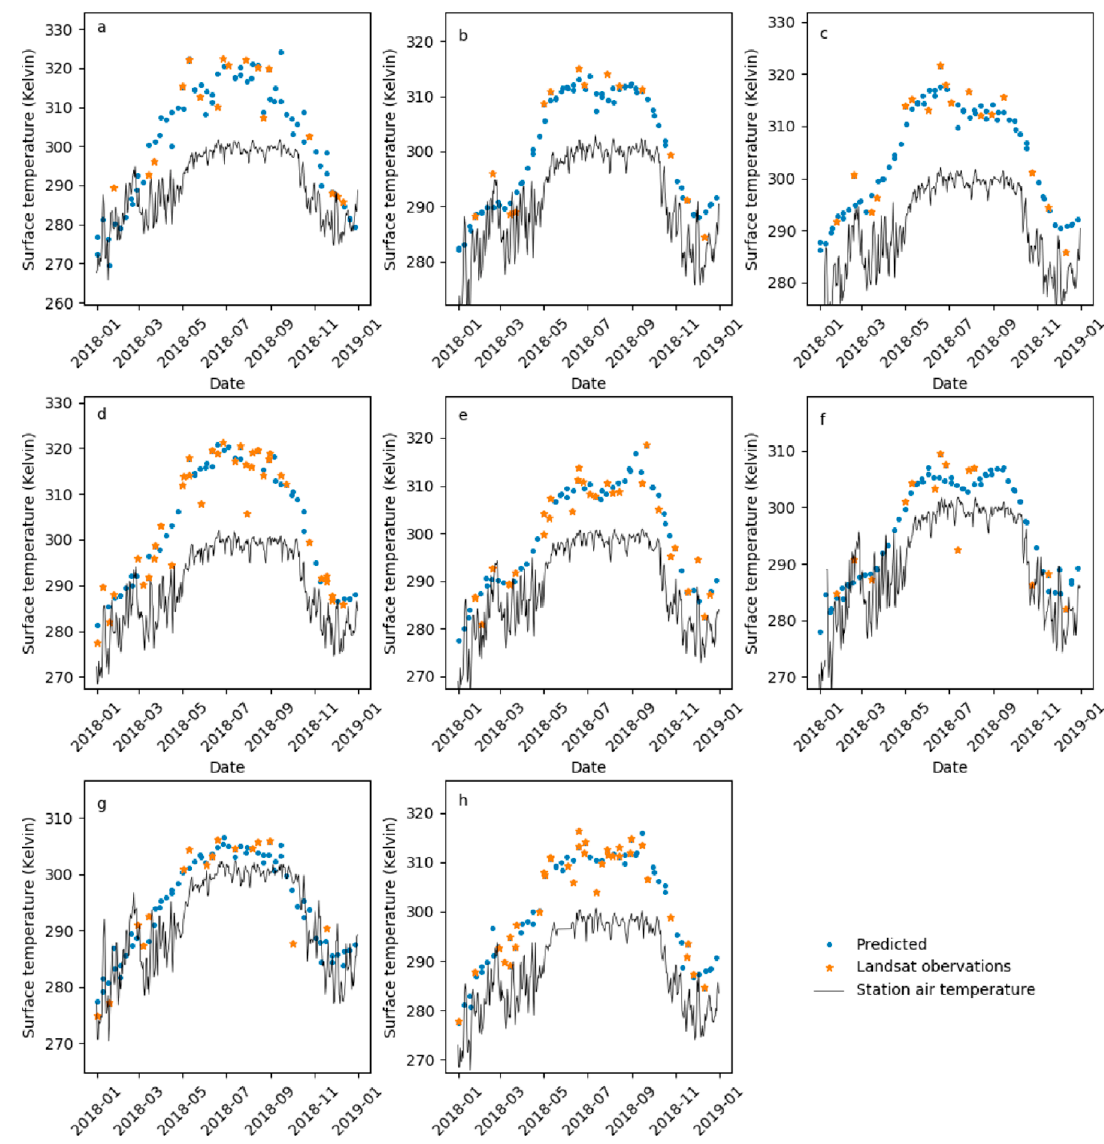
Figure 5. Time series of land surface temperature and air temperature at eight stations in Atlanta, GA. The orange stars are valid Landsat observations, and blue dots are model-predicted values at each Landsat acquisition date. The black lines are station air temperatures [37] (https://www.ncdc.noaa.gov/ghcn-daily-description). The station ID and latitude–longitude are ( a ): USW00053863(33.875,